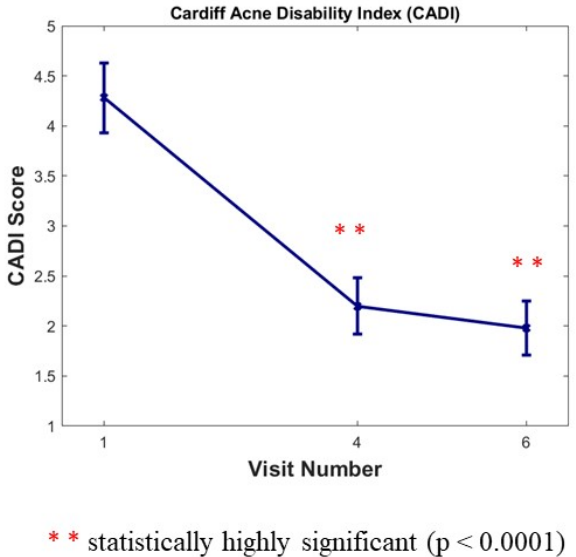
Figure 4. Cardiff Acne Disability Index (CADI) score 0 to 20. Results are expressed as means ± SD; a large statistically significant decrease versus baseline after 6 months (Visit 4) and after 12 months (Visit 6) for this index ( p < 0.0001).